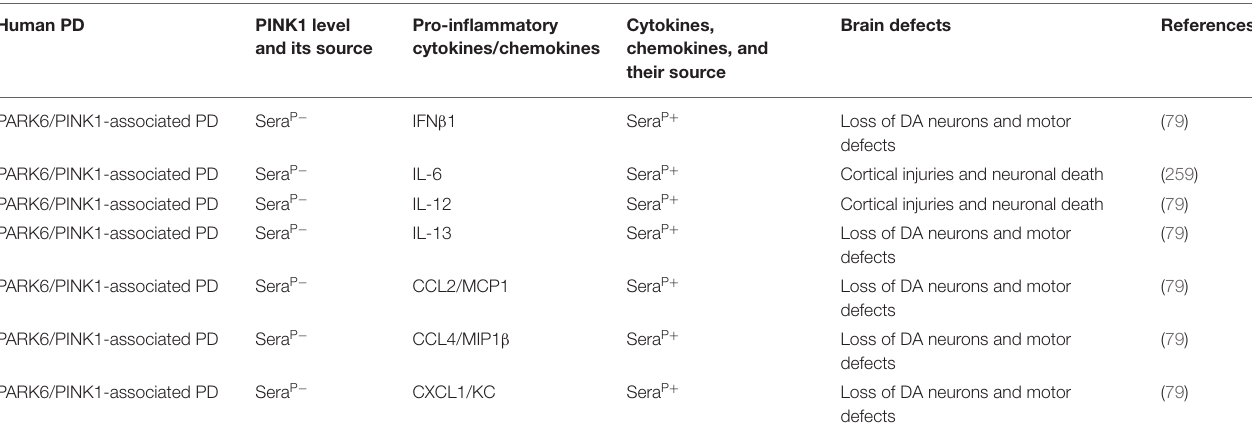
TABLE 6B | Cytokines and their source in the PARK6-associated human